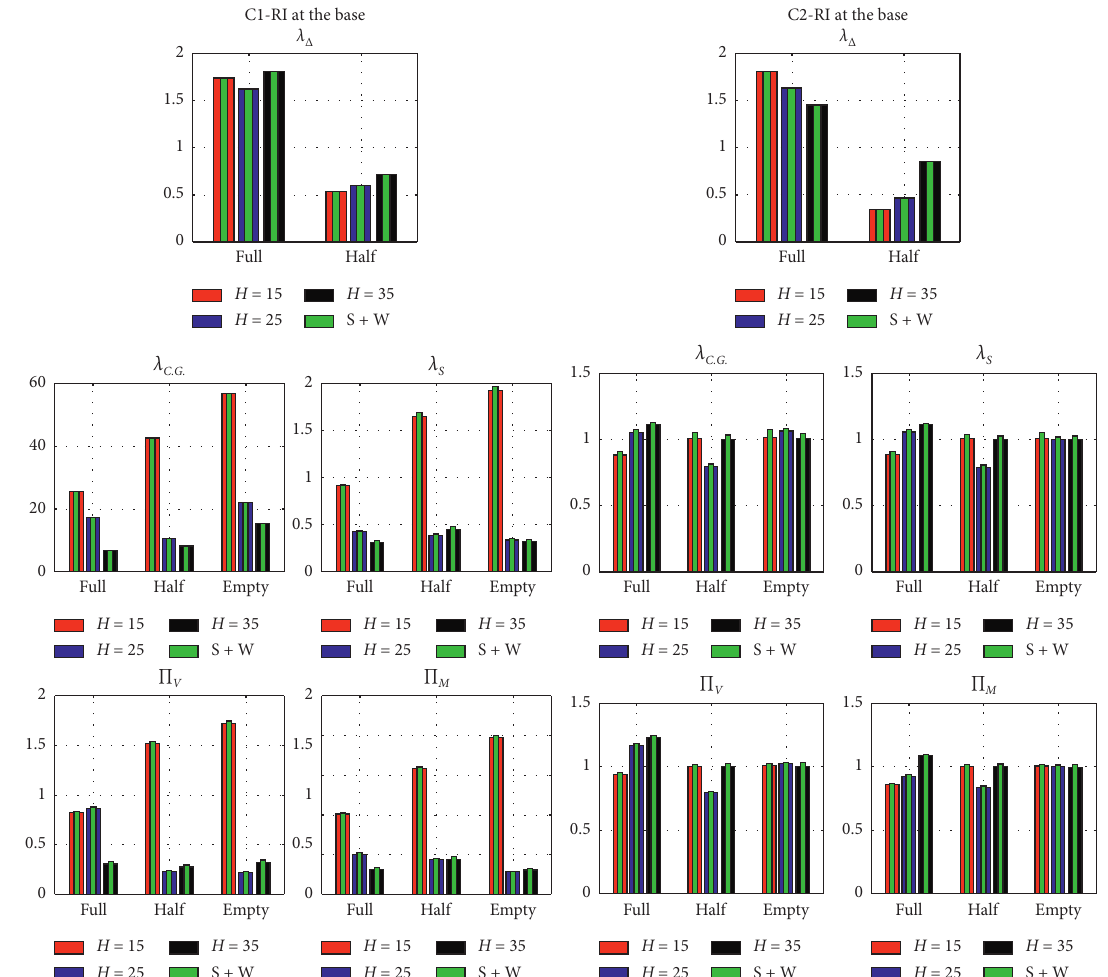
Figure 23: Maximum performance parameters of the prototypes under various lateral load combinations (green bars: seismic